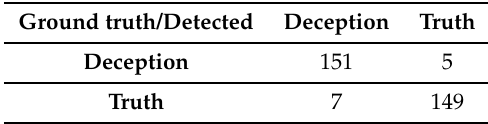
Table 7. Confusion matrix for deceitful behavior detection based on blink rates.